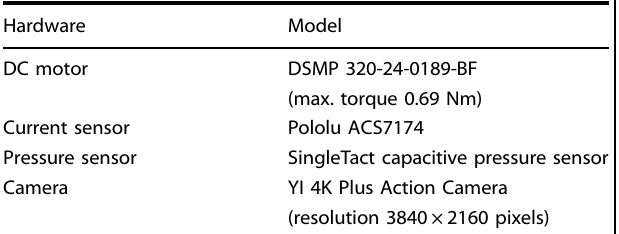
Table 1. References for hardware used on the piston-probing experimental setup.